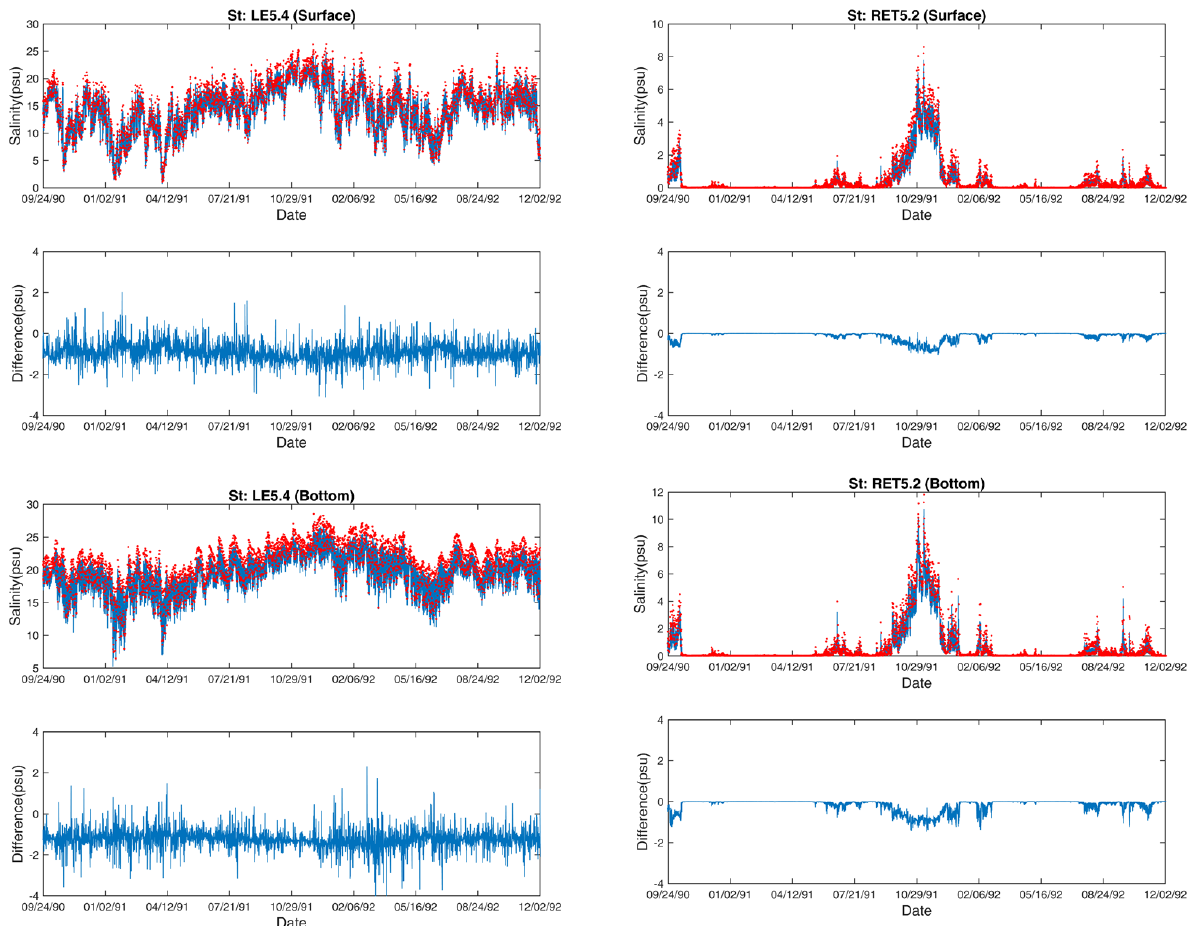
Figure 13. Comparison of the change in salinity with open boundary salinity reductions by 5% at Stations LE5.4 and RET5.2 (red lines are the baseline condition; blue lines are the sensitivity run; and the difference shows the difference btween the sensitivity run and the baseline run).